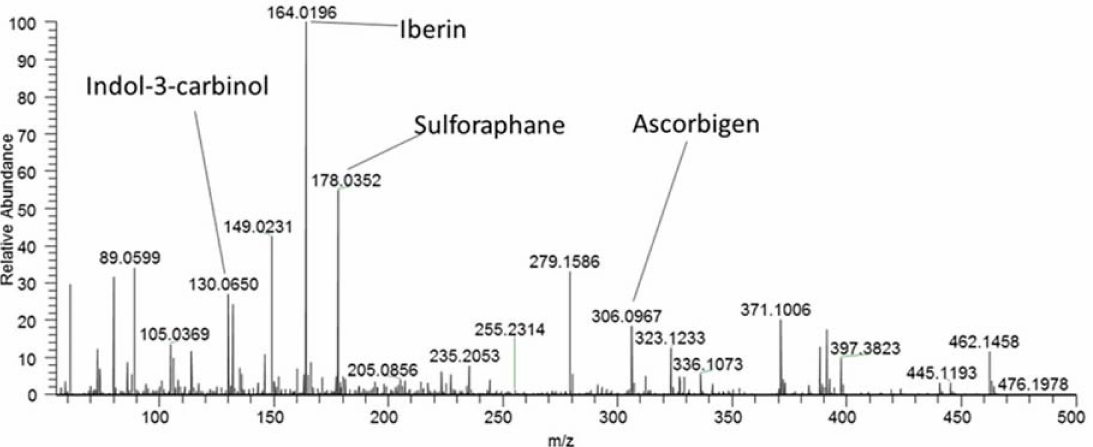
Figure 1. DART-Orbitrap-MS spectrum of an ethylacetate extract of Albatros cv. (integrated production) measured in the positive ionization mode. The identified GSL degradation products are described in Table